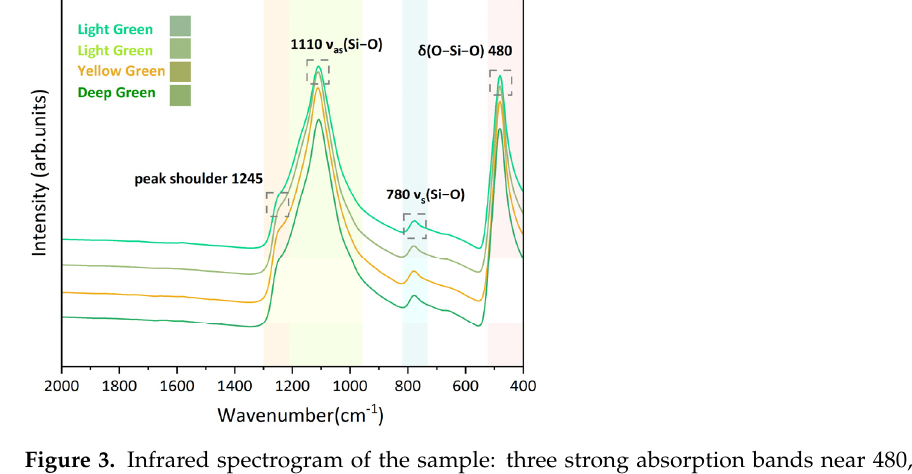
Figure 3. Infrared spectrogram of the sample: three strong absorption bands near 480, 780, and 1110 cm − 1 , and an inflection point near 1245 cm − 1 .